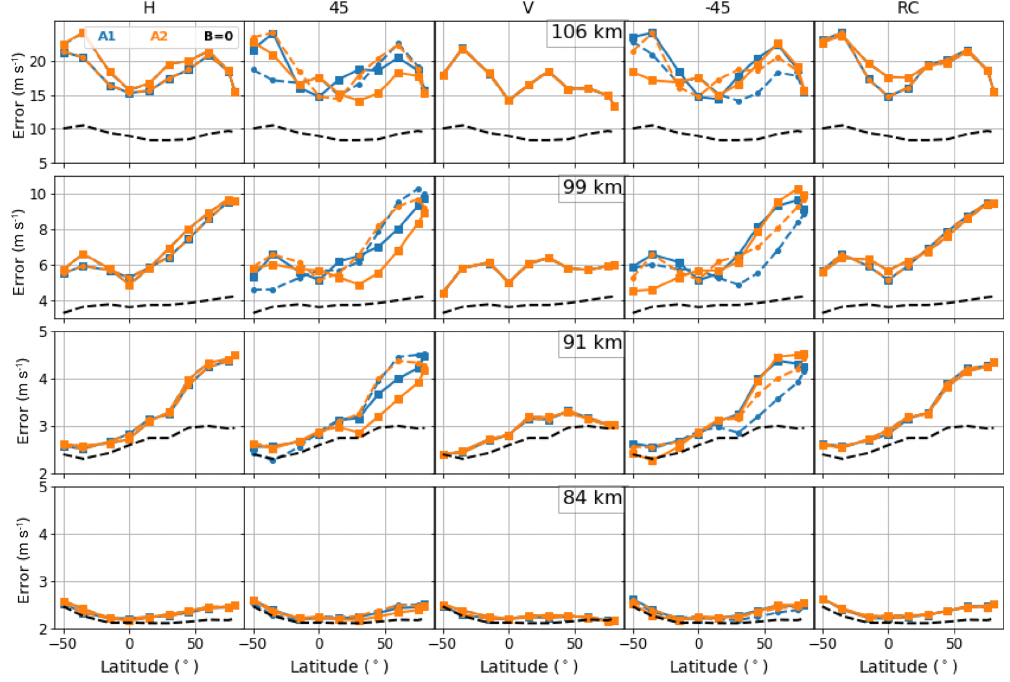
Figure 10. Same as Fig. 9 but for LOS wind